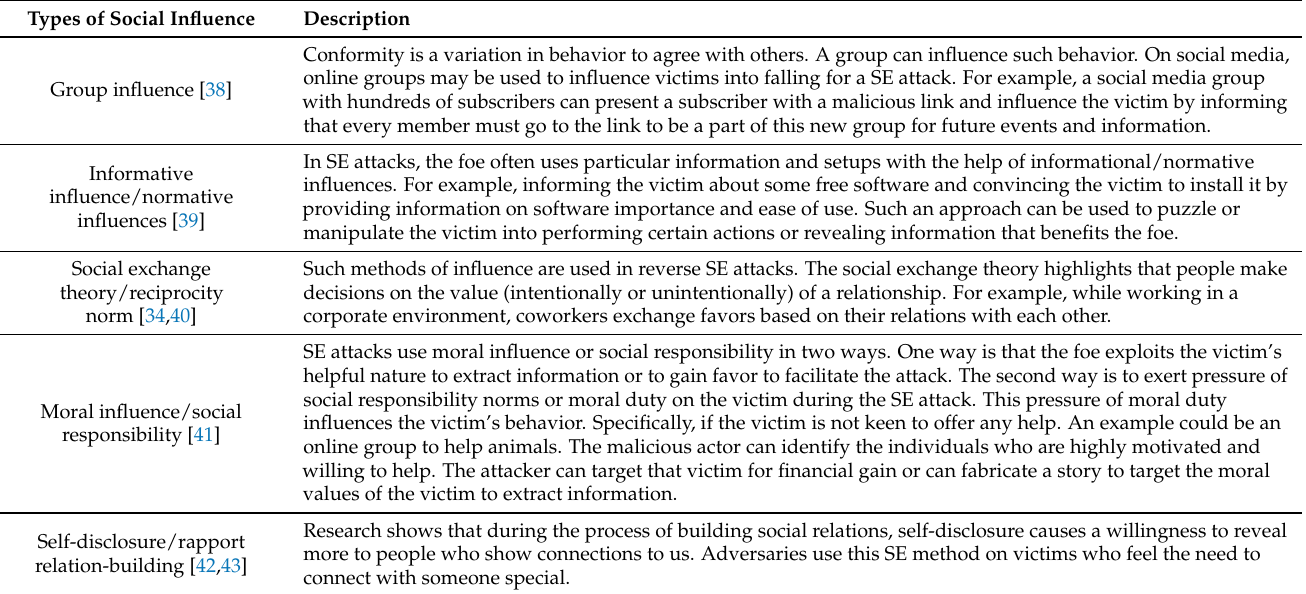
Table 3. Social influence methods related to cyberattacks based on social